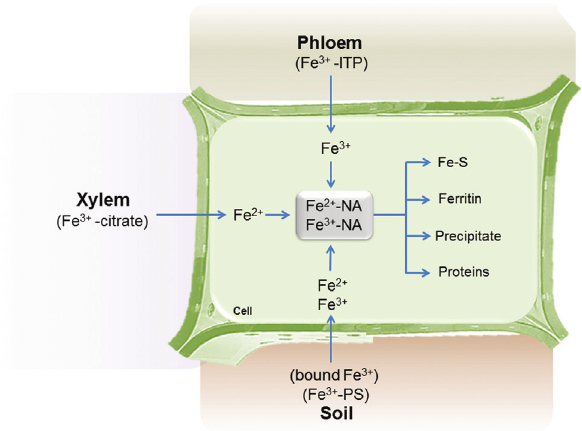
Figure 2 - Role of nicotianamine (NA) in iron metabolism in plant cells. Iron can enter the plant cell through various strategies depending on the nature of the iron source. In this context NA is an important chelator that is abletoprovideironinafunctionalform,avoidingprecipitationandcataly- sis. Adapted from Hell and Stephan